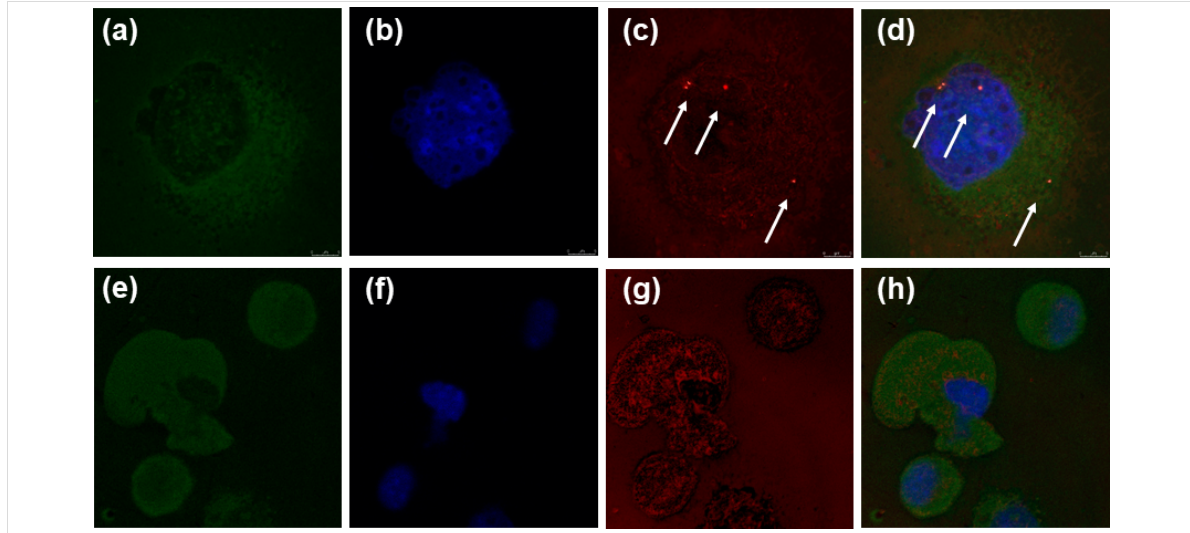
Figure 5: The NP uptake within L929 cells (a–d) compared to untreated control cells (e–h) as visualized by reflection mode confocal laser scanning microscopy (CLSM). The images show maximum intensity Z-projections of cells stained with phalloidin to stain actin and visualize cell cytoskeleton (green), nucleic acid staining using Hoechst 33258 fluorescent dye (blue) and CLSM reflectance signals (red). The overlay of fluorescence stains and segmented reflectance signals are given in (g,h). The control cells show no high intensity reflective spots (g), while NP reflectance signals are visible as bright red signals and indicated by white arrows